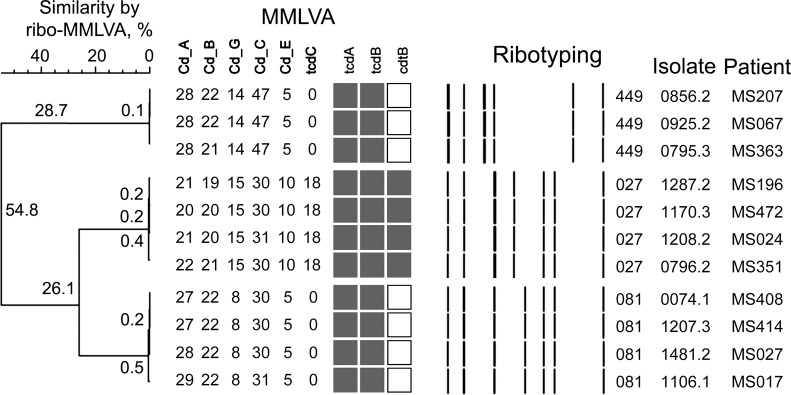
Distance between CD isolates and identifying patient clusters with identical CD isolates.MMLVA identified 5 unique patient clusters that consisted of a total of 15 individuals with highly related CD isolates. The largest clusters involved 4 patients (MS196, MS472, MS024 and MS351) with the hyper-toxin producing ribotype-027. Some clusters were epidemiologically linked in hospital at this visit (ribotype-027 group; MS196, MS472, MS024 and MS351) while other clusters had no hospital or community links in the last 90 days (ribotype-449 group; MS207, MS067 and MS363) determined using time and place analysis.